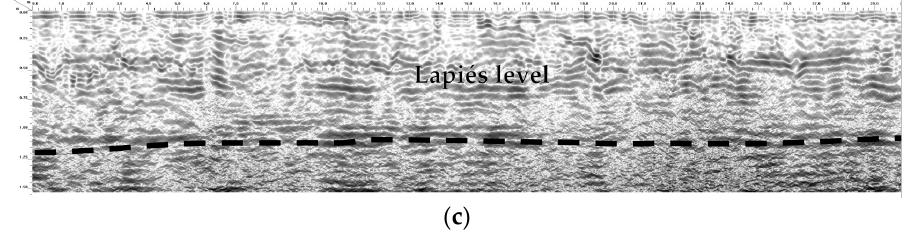
Figure 8. ( a ) Location and ( b ) radargram (profile T-97) recorded with the 400 MHz antenna, in which two levels of discontinuities in the rock mass were detected. The first and more superficial level corresponds to the lapiés (delimited with a black dashed line), and the second corresponds to a zone of fractures, joints, and detachments (delimited with a yellow dashed line). Vertical discontinuities corresponding to vertical fractures were also detected. ( c ) Radargram (profile T-97) recorded with the 900 MHz antenna, in which discontinuities with better resolution were detected at the lapiés level (delimited with a black dashed line). Vertical discontinuities corresponding to vertical fractures and rock pinnacles separated by grooves were also detected.